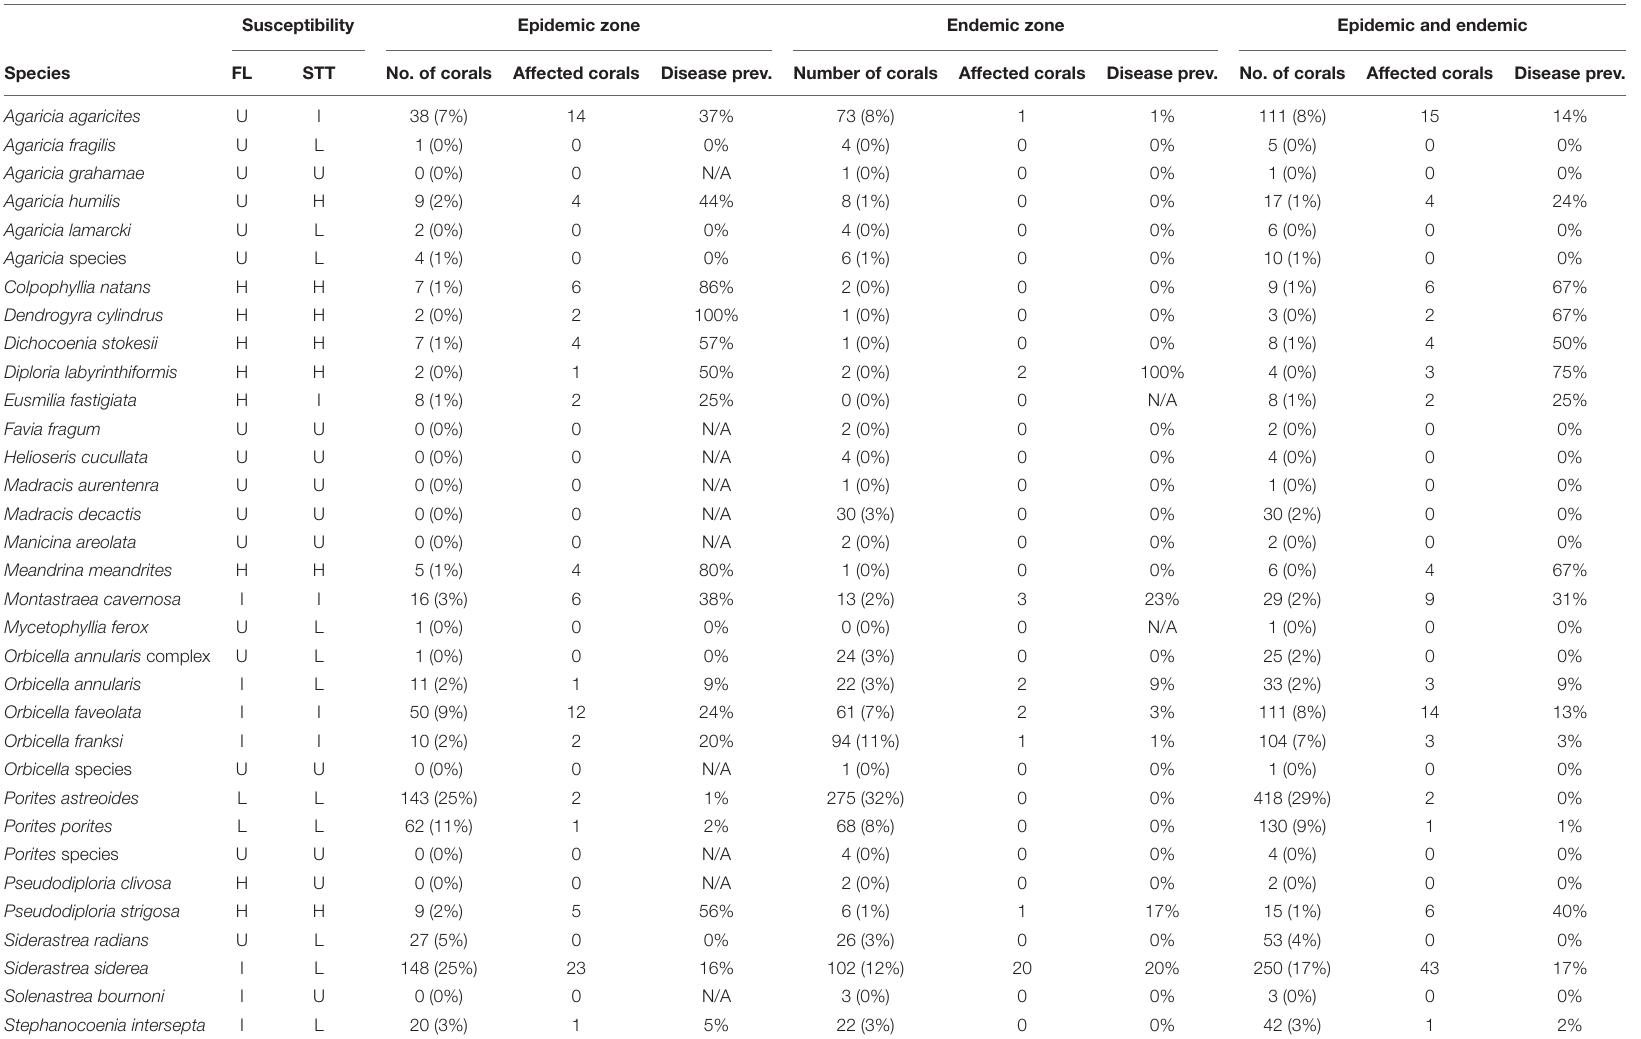
TABLE 1 | Coral species disease prevalence by zone and comparison of species susceptibility in Florida (FL), United States (SCTLD Case Definition, 2018) and this study in St. Thomas (STT),